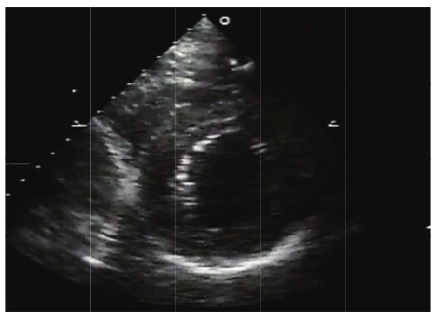
Figure 8: Echocardiography at 6-week follow-up demonstrating the resolution of the hematoma.